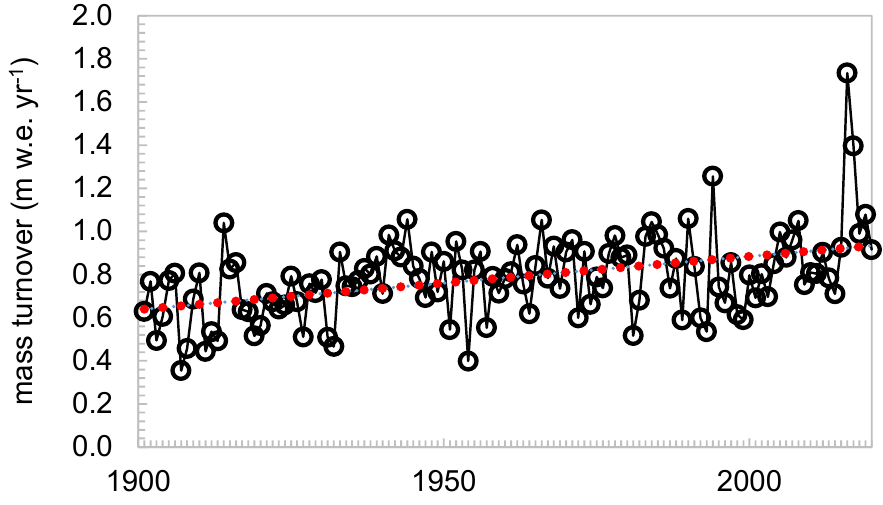
Figure 9. Annual mass turnover from 1900 to 2020 calculated following Meier et al. [47]. Red dots indicate trend